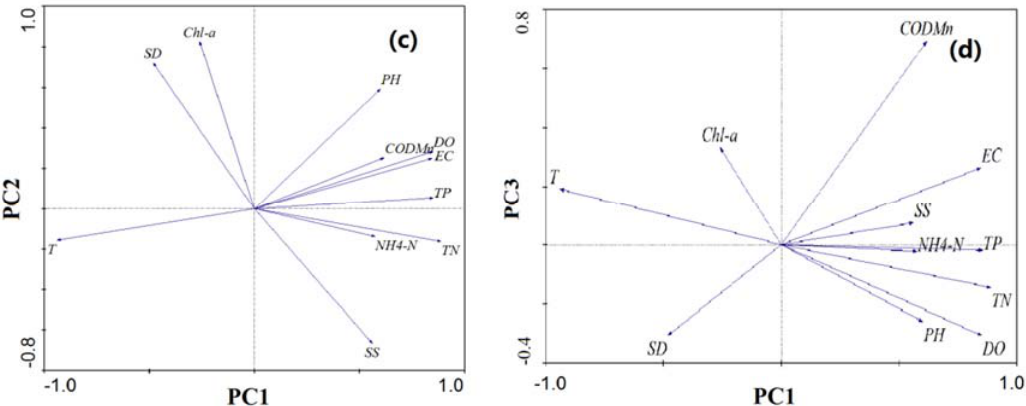
Figure 6. Principal component analysis (PCA) results of different water regimes. ( a ) scree plot of PCA; ( b ) PCA scores, where the squares represent the lake phase, the circles represent the river phase, and the red color represents the sampling sites in the northern Poyang Lake–Yangtze River waterway; ( c ) loadings of PC1 and PC2; and ( d ) loadings of PC1 and PC3.